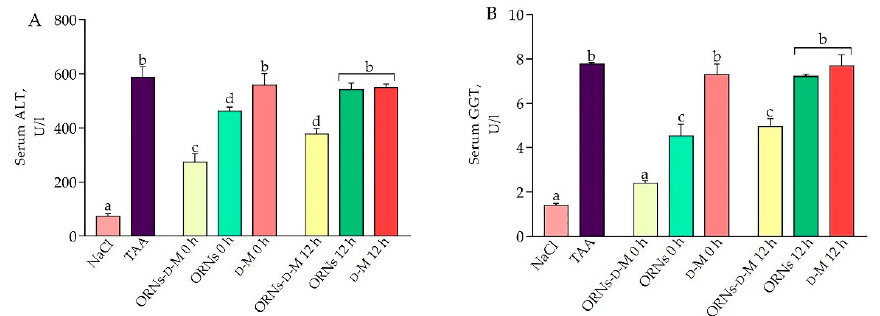
Figure 1. Effects of oligoribonucleotides- D -mannitol complexes (ORNs- D -M), natural oligoribonucleotides (ORNs) and D -mannitol (D-M) on the activities of serum ALT ( A ) and GGT ( B ) in TAA-induced liver damage mice. Data are presented as the mean ± standard deviation (SD), n = 6 for each group. Values marked with different letters (a, b, c, d) are statistically different, p < 0.05 (Student’s t -test). Abbreviations: NaCl—control mice receiving a single injection of NaCl; TAA—mice receiving a single injection of TAA; ORNs-D-M 0 h—mice receiving a TAA and ORNs- D -M immediately after TAA application (i.e., 0 h) and every next 12 h for 48 h; ORNs 0 h—mice receiving